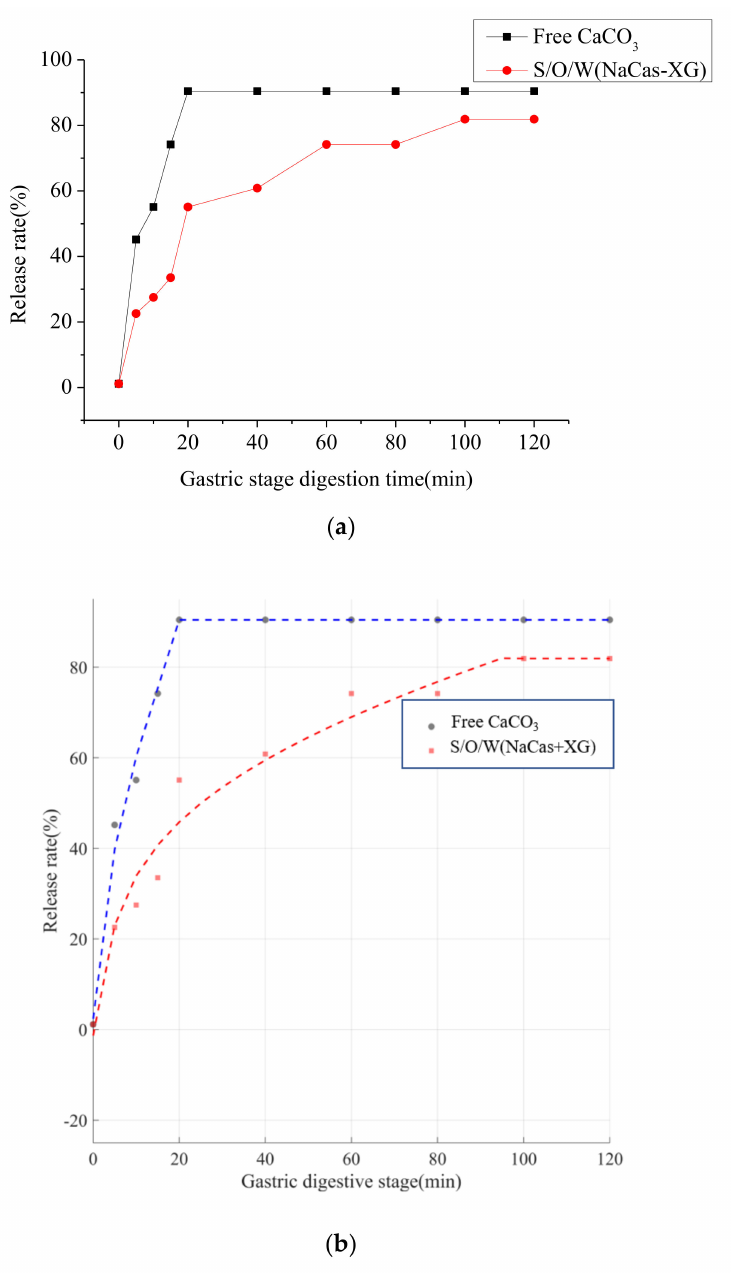
Figure 10. Ca 2+ release rate curve ( a ) and fitting curve ( b ) of CaCO 3 S/O/W emulsions in the gastric